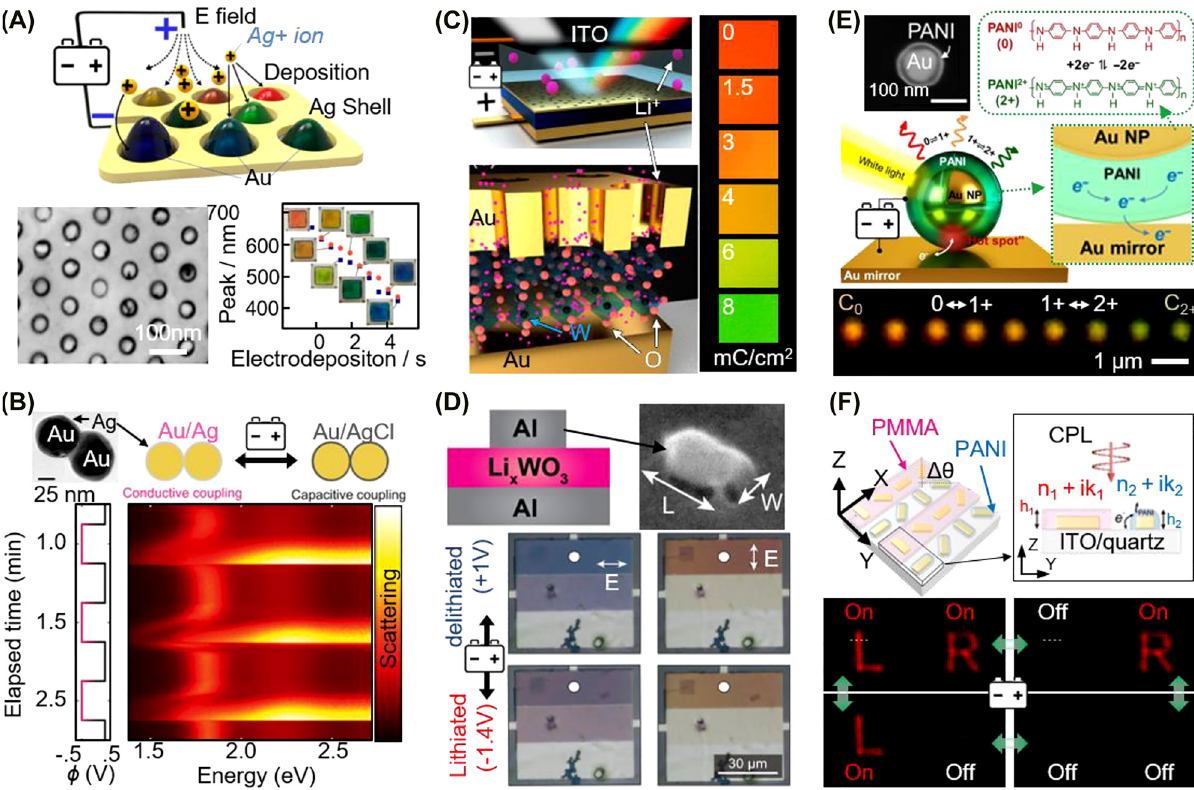
Figure 3: Electrochromic plasmonic nanopixels with modulation of the refractive index Δ n of the surrounds of the nanoparticle. Color dynamics achieved by (A) depositing/etching Ag on Au nanodomes (reproduced with permission [112], Copyright 2016, American Chemical Society), (B) changing material state from Ag (metal) to AgCl (dielectric) in the gap between two plasmonic Au